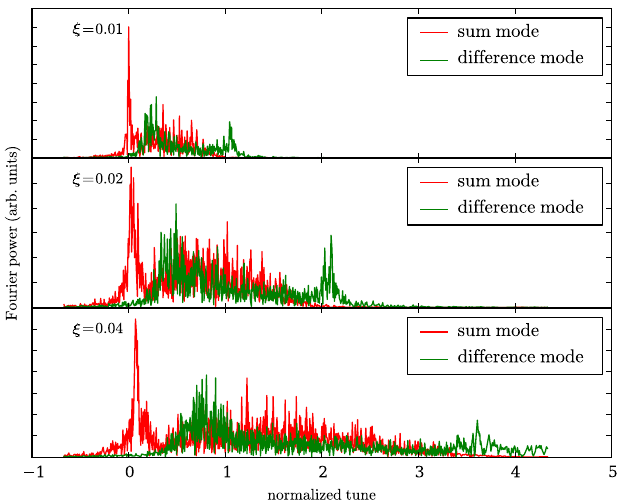
offsets of two beam centroids at three beam intensities corre- sponding to beam-beam parameter values for each beam of 0.01, 0.02, and 0.04. The vertical scale is in arbitrary units.